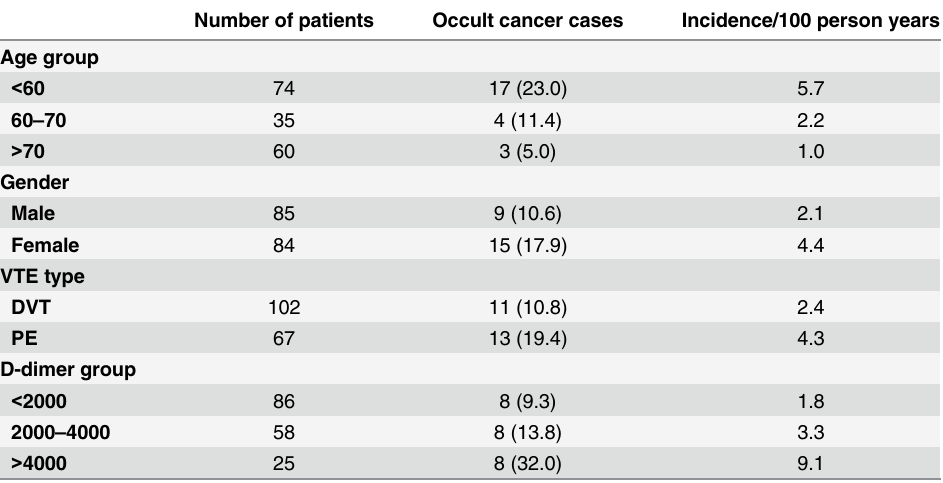
Table 3. Incidence of occult cancer according to patient risk factors.